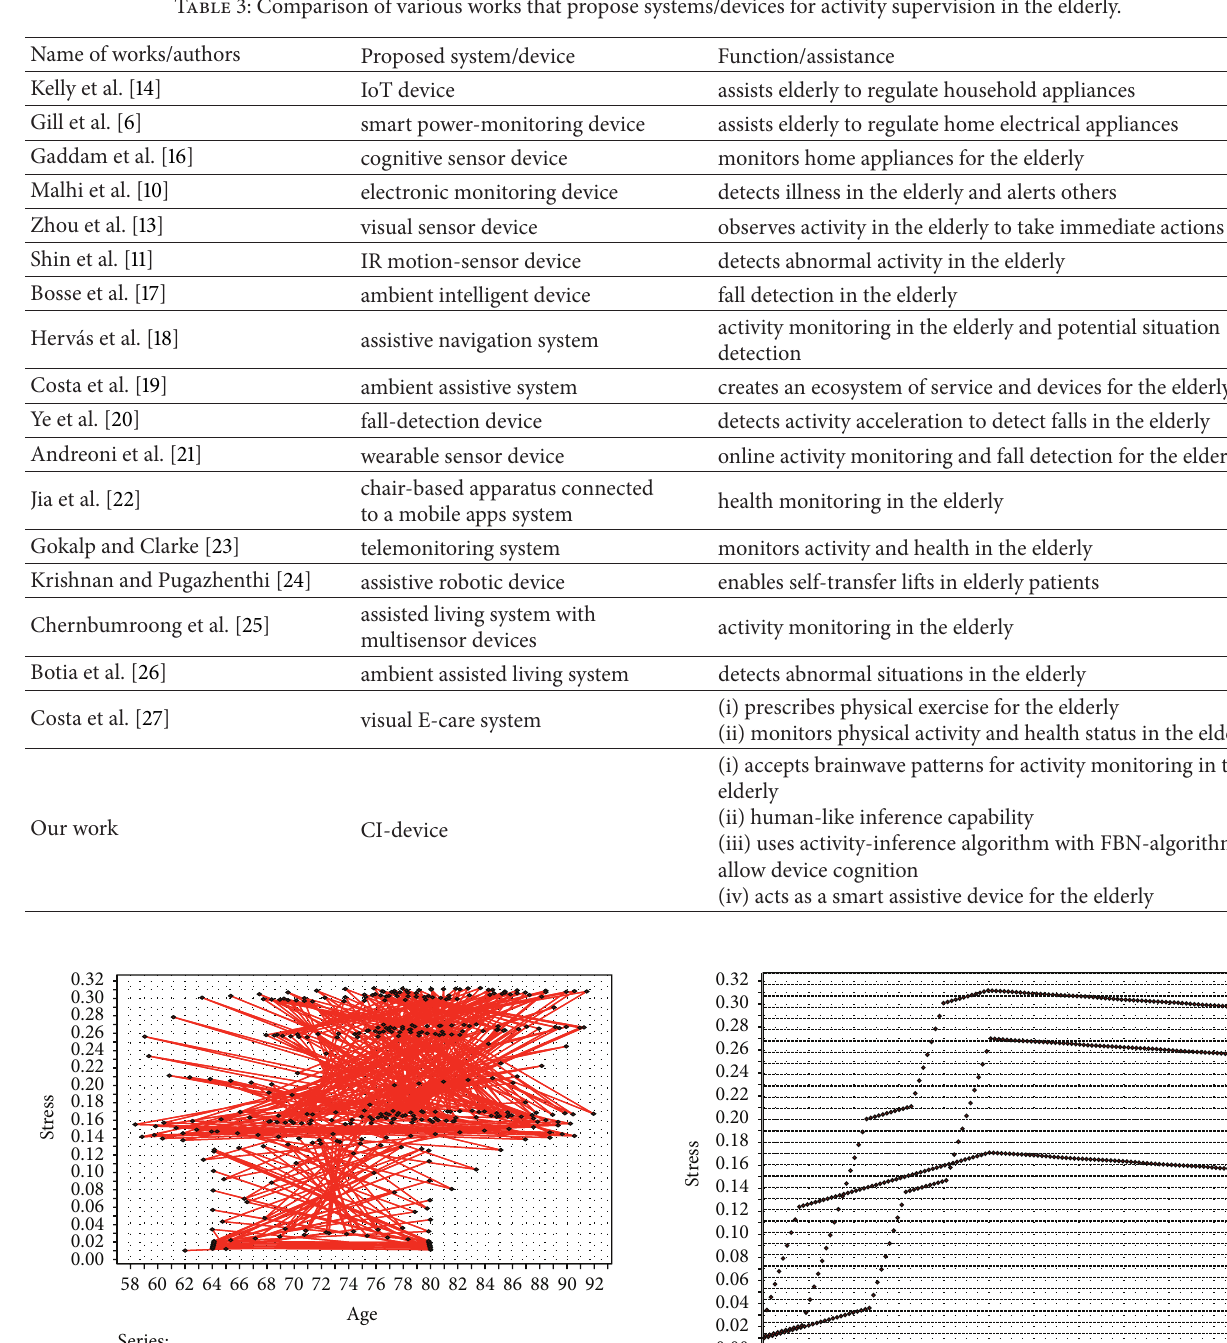
Table 3: Comparison of various works that propose systems/devices for activity supervision in the elderly.